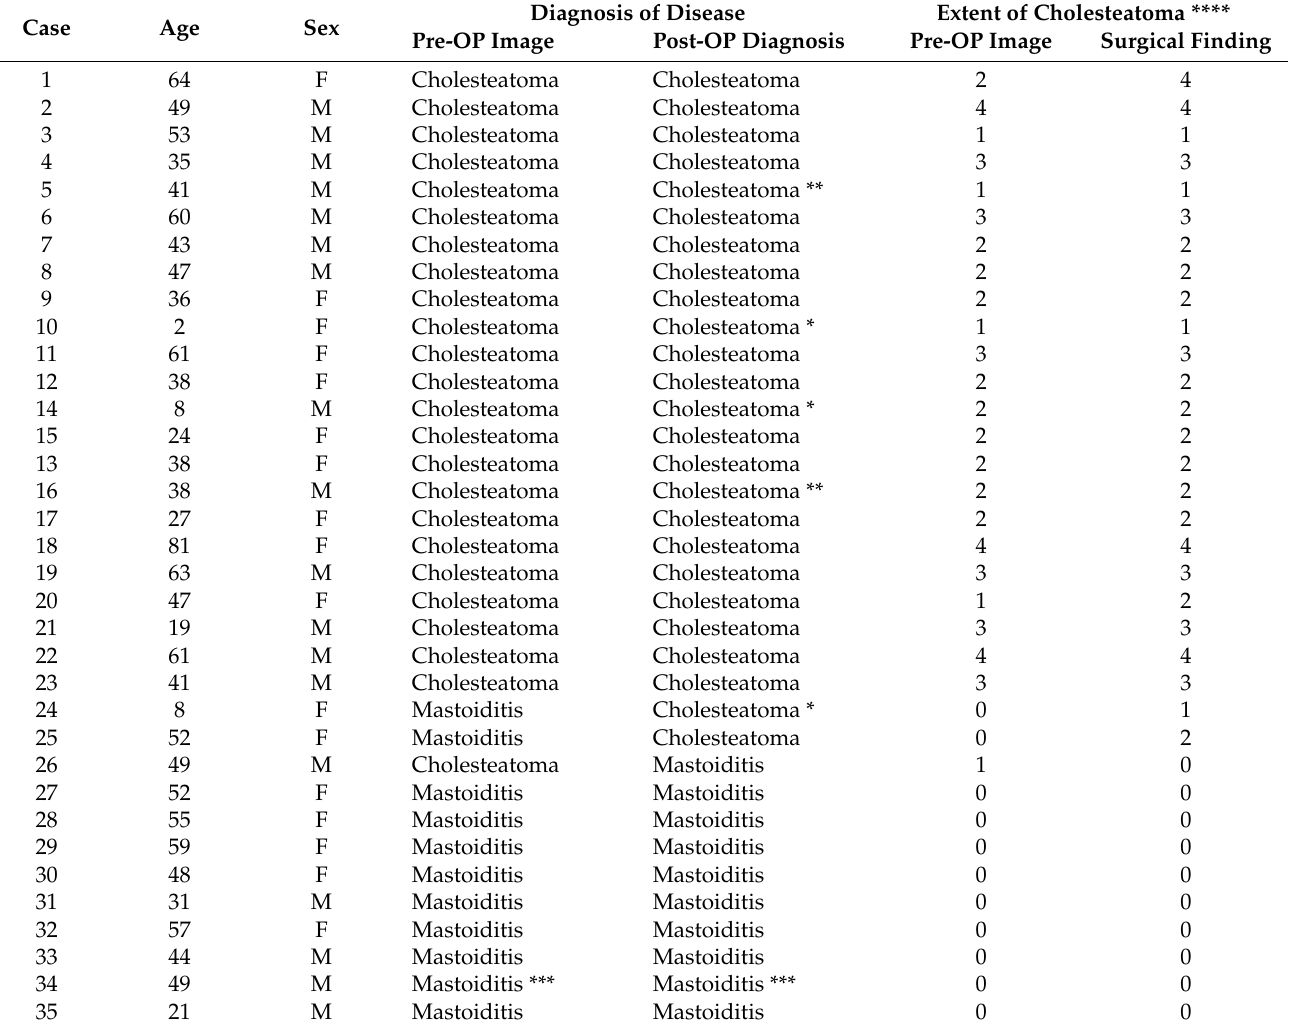
Table 1. Summary of cases regarding preoperative image assessment, diagnosis, and surgical findings.